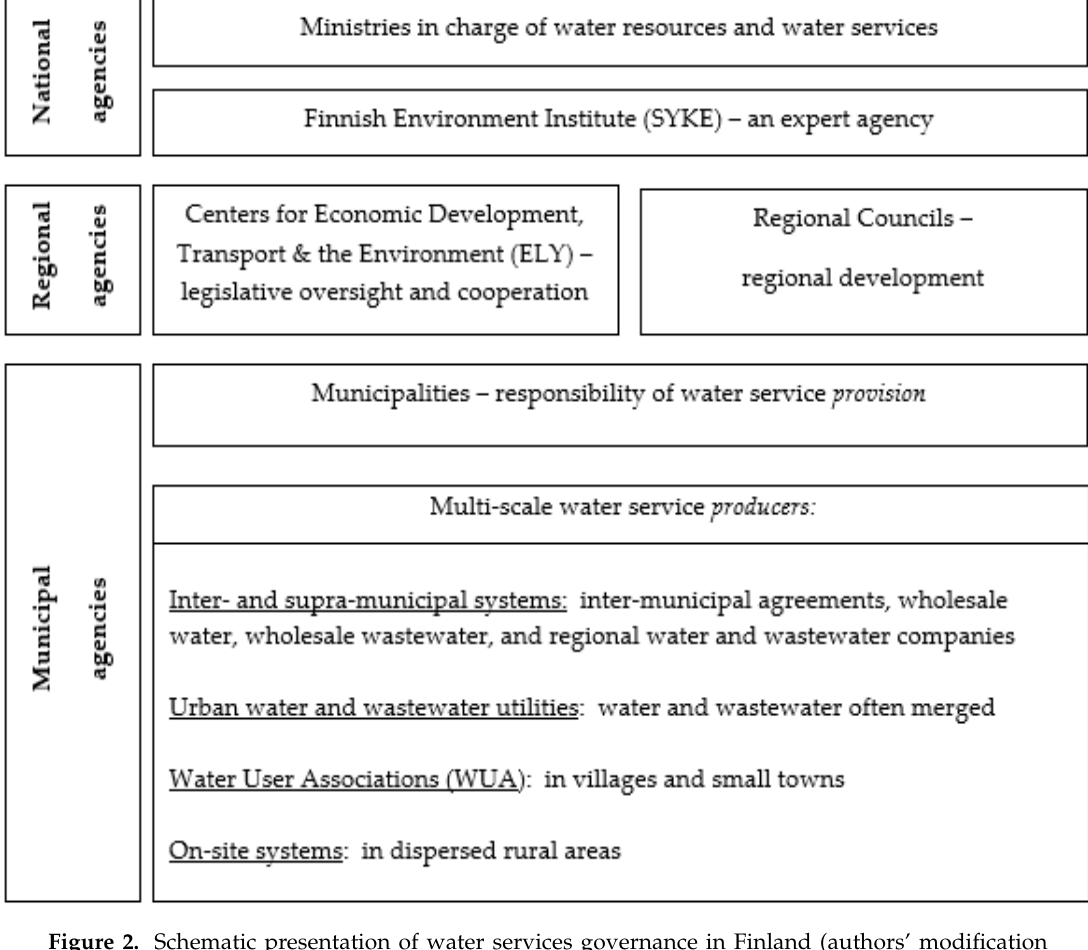
Figure 2. Schematic presentation of water services governance in Finland (authors’ modification from [17]).